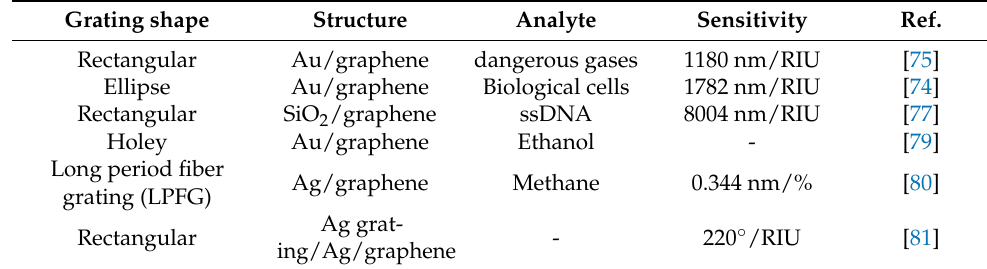
Table 4. A summary of selected papers regarding graphene-based grating coupled SPR biosensor.